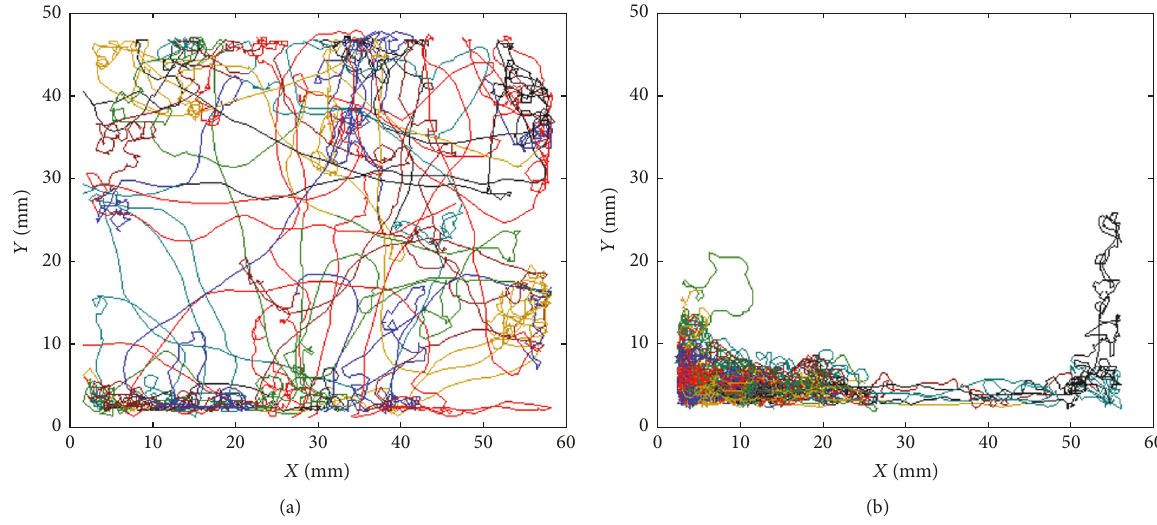
Figure 2: Movement tracks of Daphnia magna treated with toluene at 10mg/L. (a) Before treatment and (b) after treatment. Colors on tracks indicate movement segments in 10s time interval.